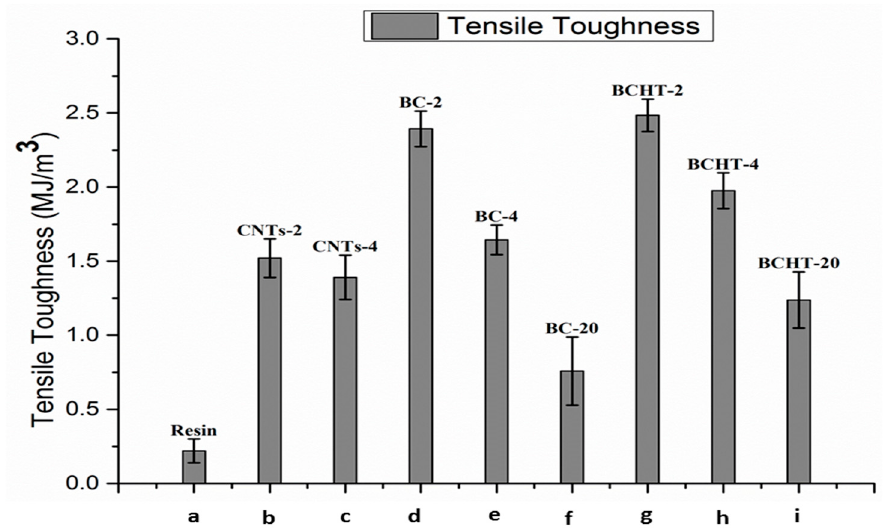
Figure 8. Tensile toughness comparison: ( a ) Neat epoxy; ( b ) MWCNTs 2 wt %; ( c ) MWCNTs 4 wt %; ( d ) biochar 2 wt %; ( e ) biochar 4 wt %; ( f ) biochar 20 wt %; ( g ) biochar HT 2 wt %; ( h ) biochar